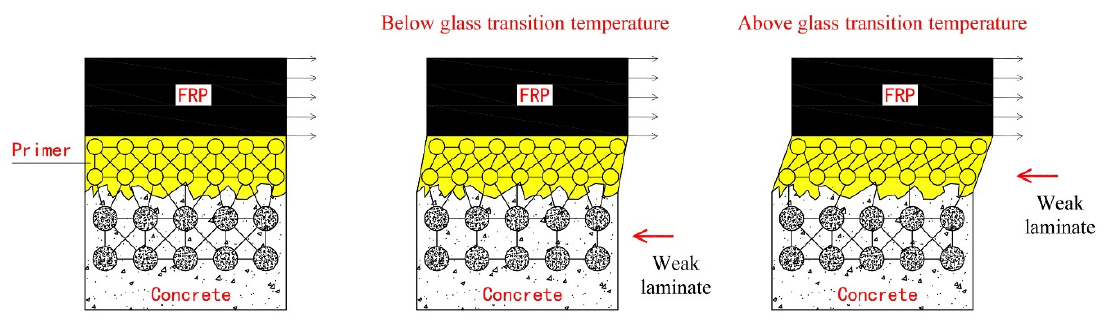
Figure 12. Schematic illustration of the degradation mechanism.